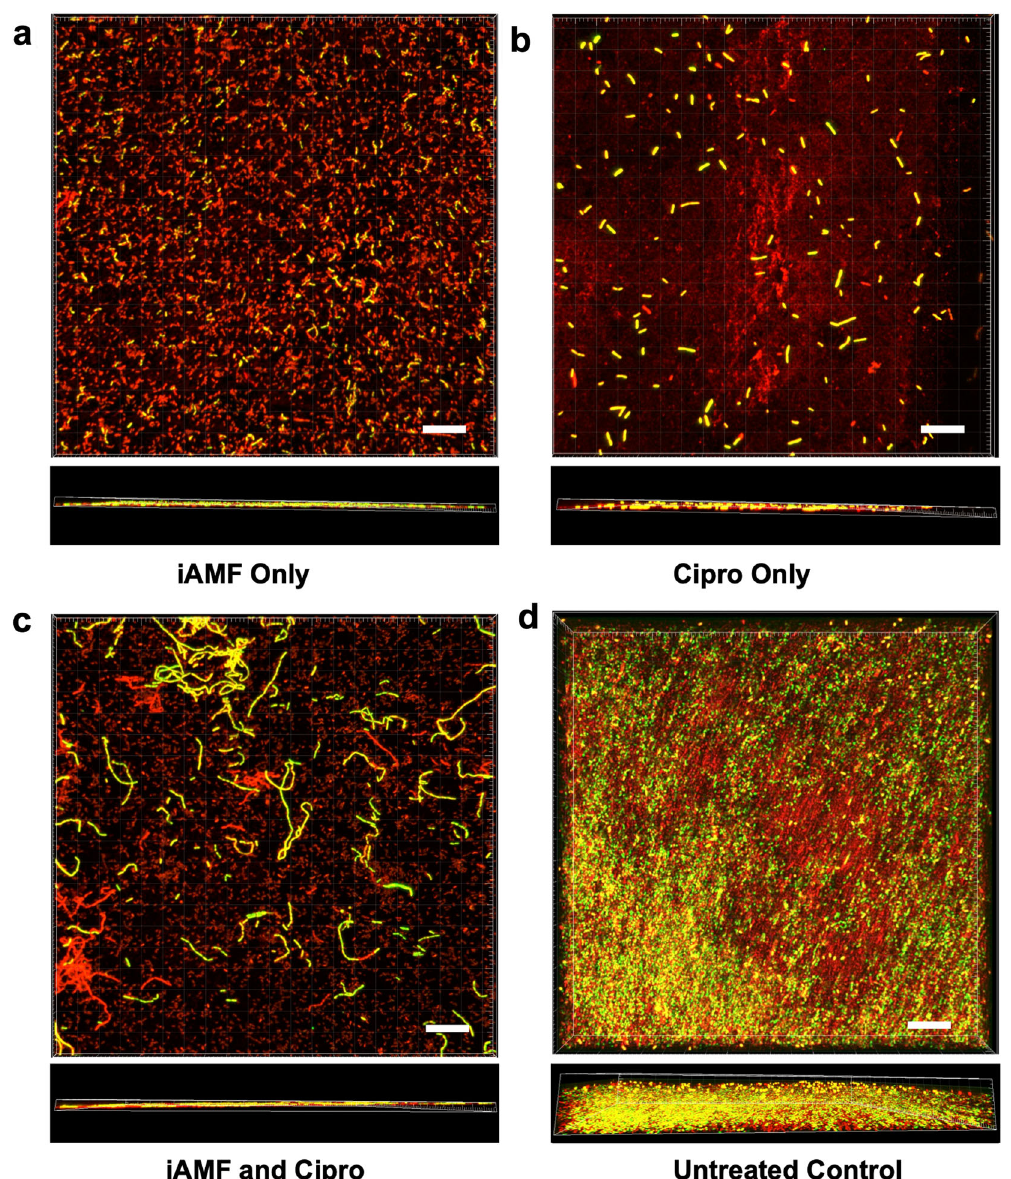
Fig. 3 iAMF and cipro fl oxacin cause bacterial morphologic changes. Laser scanning confocal microscopy of P. aeruginos a (PAO1) bio fi lm- infected rings 12 h post start of treatment (top and side views). Bacteria within the bio fi lm express a green fl uorescent protein (GFP) while EPS are stained with ConcanavalinA-Alexa Fluor 647 conjugate, fl uorescing red. Rings were a treated with iAMF ( T max = 65 °C) for 1 h, then incubated in MHII media for 12 h, b incubated in cipro fl oxacin at 0.5 μ g mL − 1 for 12 h or c treated with 1 h iAMF while incubating with 0.5 μ g mL − 1 of cipro fl oxacin for 12 h. d Untreated control. Scale Bar: 100 μ